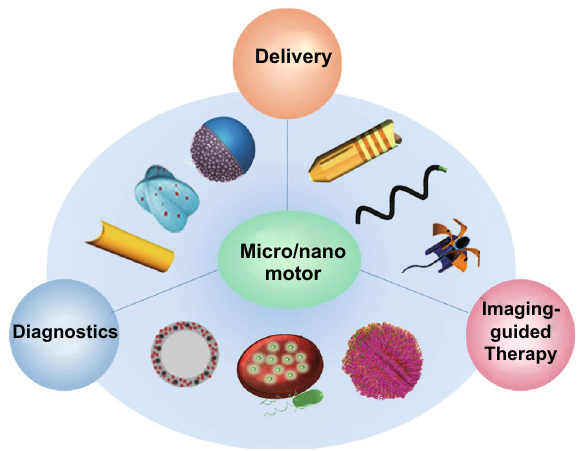
Fig. 1 Schematic illustration of micro/nanomotors for cancer diagno- sis and